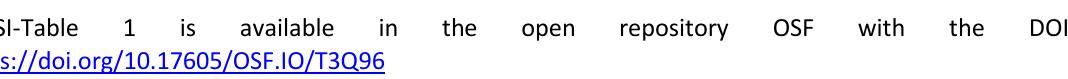
is available in the open